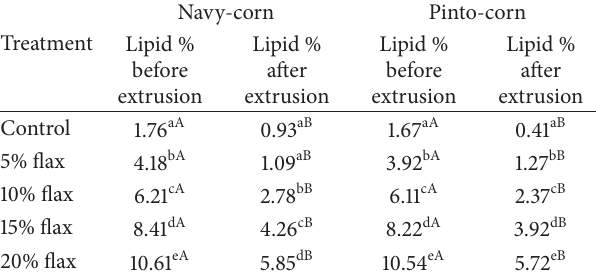
Table 3: Lipid content of the bean-corn flour mix and extrudates. Navy-corn Treatment